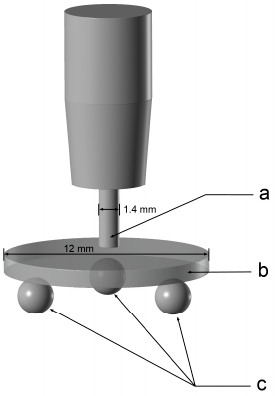
Figure 2. The shape and dimension of the test specimens used.